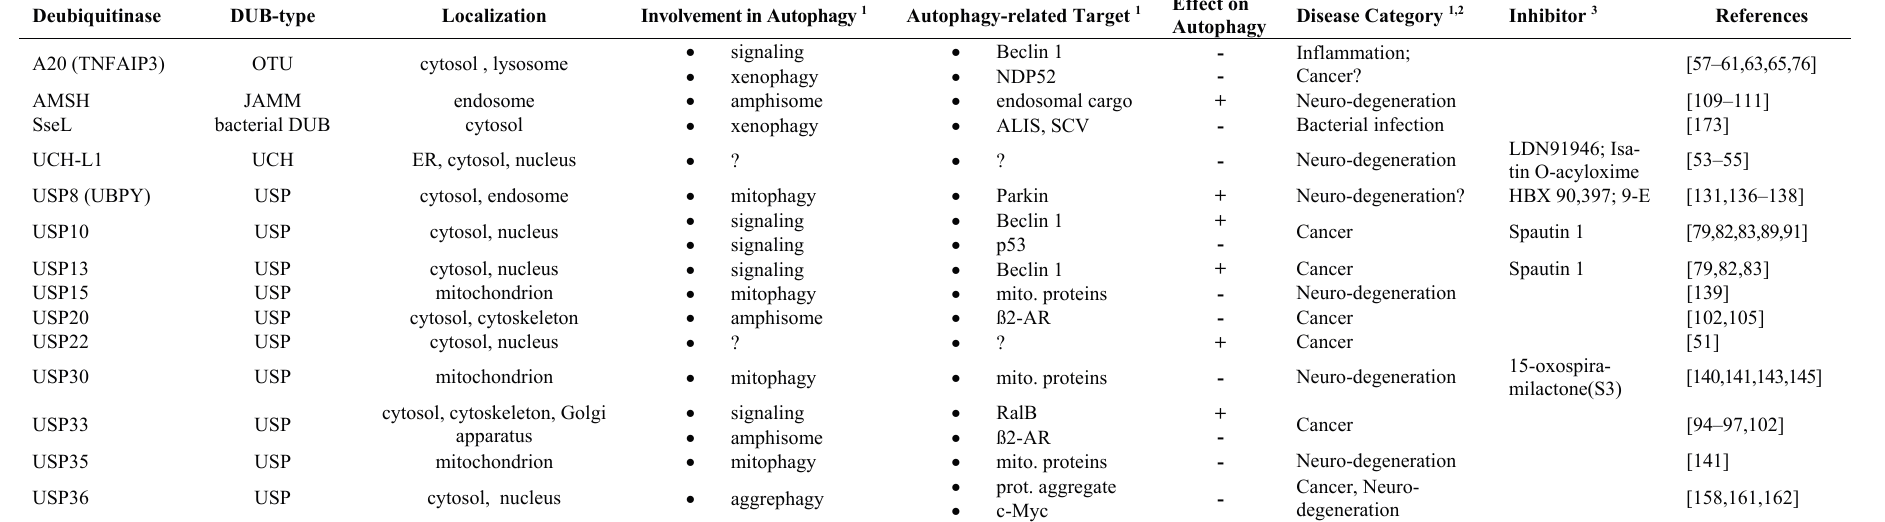
Table 1. List of deubiquitinating enzymes involved in autophagy. An overview of the involvement of deubiquitinases in autophagy. Listed are the names (deubiquitinase), enzymatic sub-family (DUB-type), intracellular localization (localization), their role in certain parts of the autophagy-pathways (involvement in autophagy), the known autophagy-relevant target (autophagy-related target), their general effect on the progression of autophagy (effect), the general type of disease they are associated with (disease-type), known specific inhibitors (inhibitors), as well as important citations